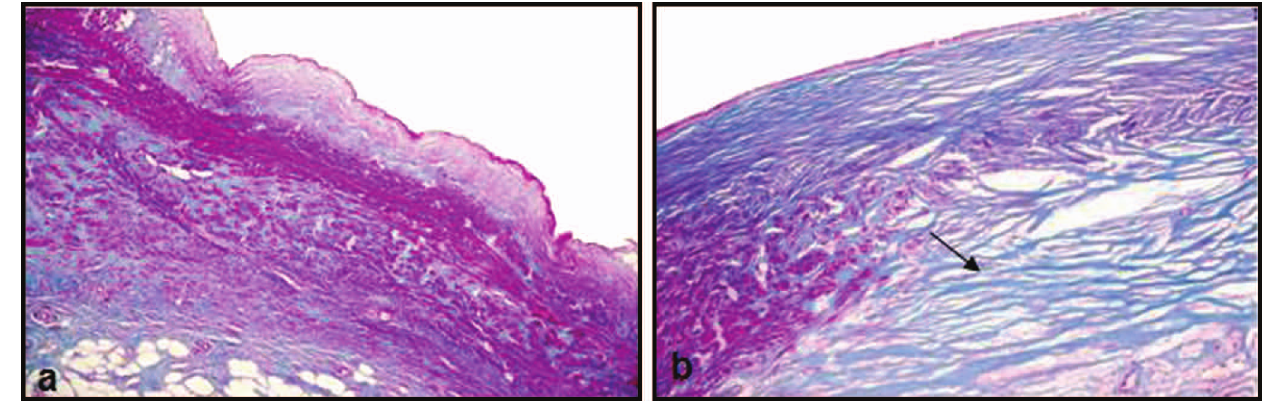
Fig. 2. Histological section of piapara Leporinus obtusidens swimbladder (Masson trichromic staining, 10x). In a swimbladder with sac-like projection, the muscle layer (purple) was replaced by fibrous connective tissue (blue).